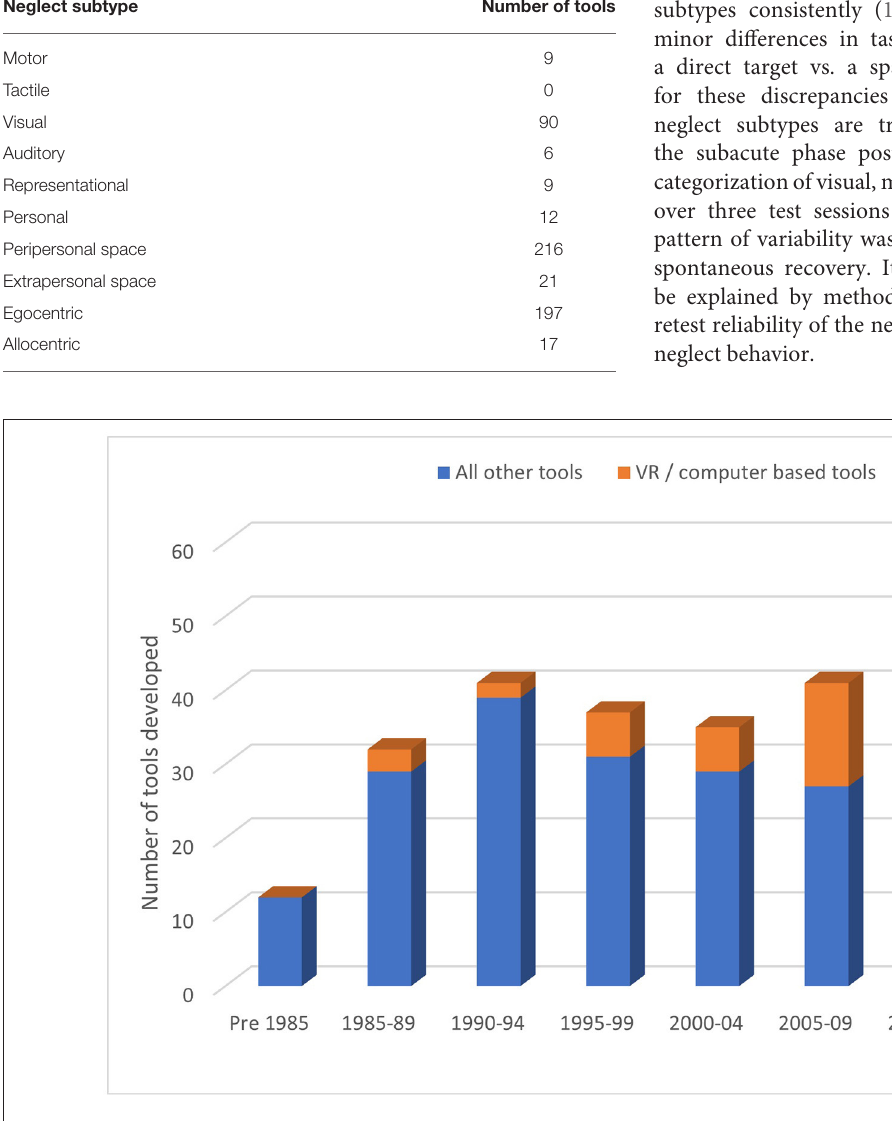
FIGURE 10 | Number of virtual reality and computer-based tools.